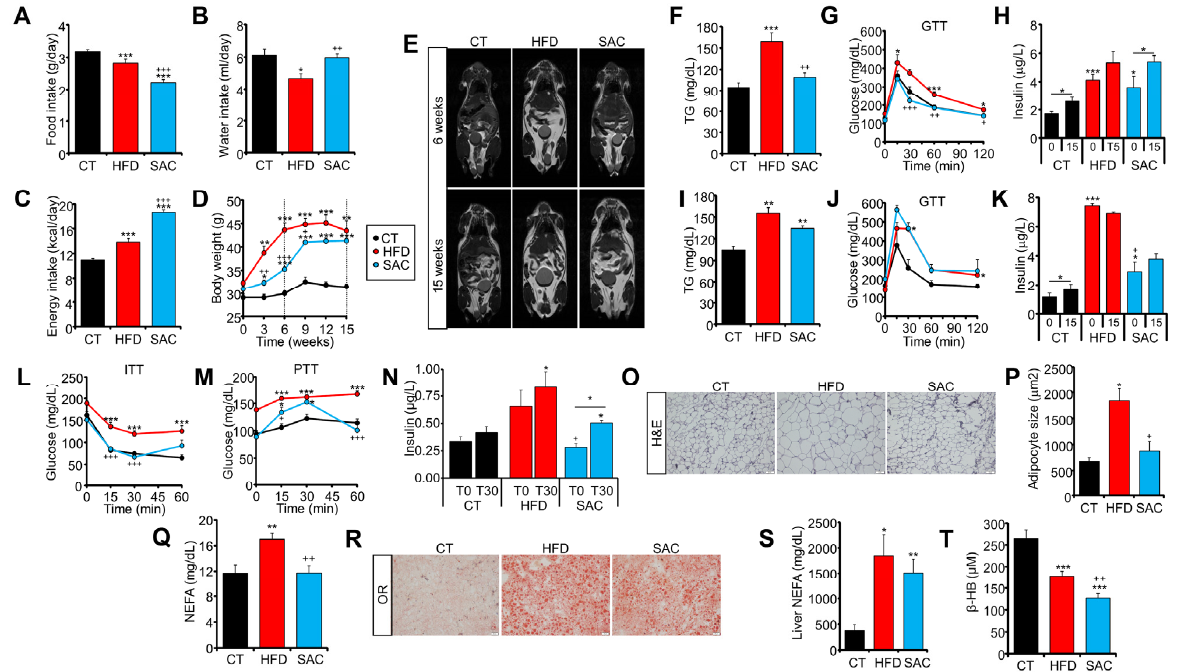
Figure 1. High-fat and high-sucrose diets lead to a convergent obese phenotype over time. ( A – C ): Food ( A ) and drink ( B ) intake and calories consumed ( C ) by male C57BL/6J mice fed either standard chow (CT), a high-fat diet (HFD), or standard chow with drinking water supplemented with 50% sucrose (SAC). ( D ) Body weight of the same mice during 15 weeks of diet. ( E ) Magnetic resonance imaging (MRI) analysis of fat distribution of the same mice after 6 (top panels) and 15 weeks (lower panels) of diet. ( F – H ): After 6 weeks, HFD mice are hypertriglyceridemic ( F ), glucose intolerant ( G ), and hyperinsulinemic ( H ), whereas SAC mice are hyperinsulinemic. ( I – K ): After 15 weeks, both HFD and SAC mice are hypertriglyceridemic ( I ), glucose intolerant ( J ), and hyperinsulinemic ( K ). ( L ) After 6 weeks, HFD mice, but not SAC mice, are insulin resistant according to an insulin tolerance test (ITT). ( M , N ): SAC mice show increased gluconeogenesis ( M ) and insulin release ( N ) during a pyruvate tolerance test (PTT), evidencing hepatic insulin resistance. ( O – Q ): Epididymal white adipose tissue (eWAT) of HFD mice shows adipocyte hypertrophy ( O , P ) and increased levels of plasma non-esterified fatty acids (NEFA) ( Q ). ( R – T ): Livers of both HFD and SAC mice show hepatic steatosis ( R ), increased NEFA content ( S ) and decreased levels of β -hydroxybutyrate ( β -HB) ( T ). n = 6/group ( A – D , F – N , Q , S , T ), n = 3/group (E), n = 4/group ( O , P , R ). * p < 0.05, ** p < 0.01, and *** p < 0.005 with respect to the CT group unless otherwise indicated. + p < 0.05, ++ p < 0.01, and +++ p < 0.005 with respect to the HFD group. GTT = glucose tolerance test; H&E = hematoxylin and eosin; OR = oil red; TG = triglycerides.